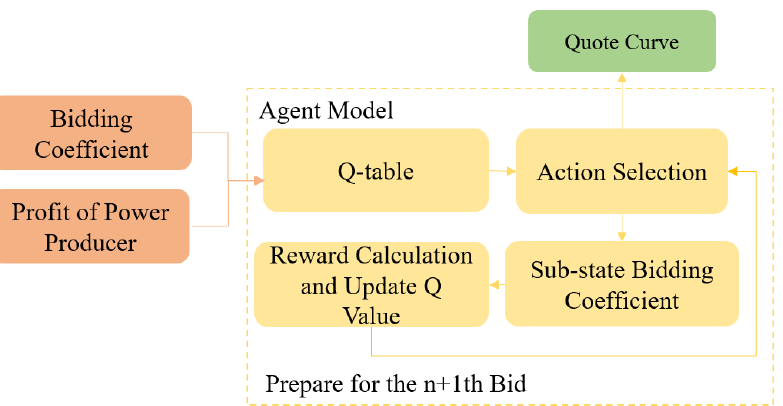
Figure 2. The typical Q-Learning-based model for the bidding strategy making module from Figure